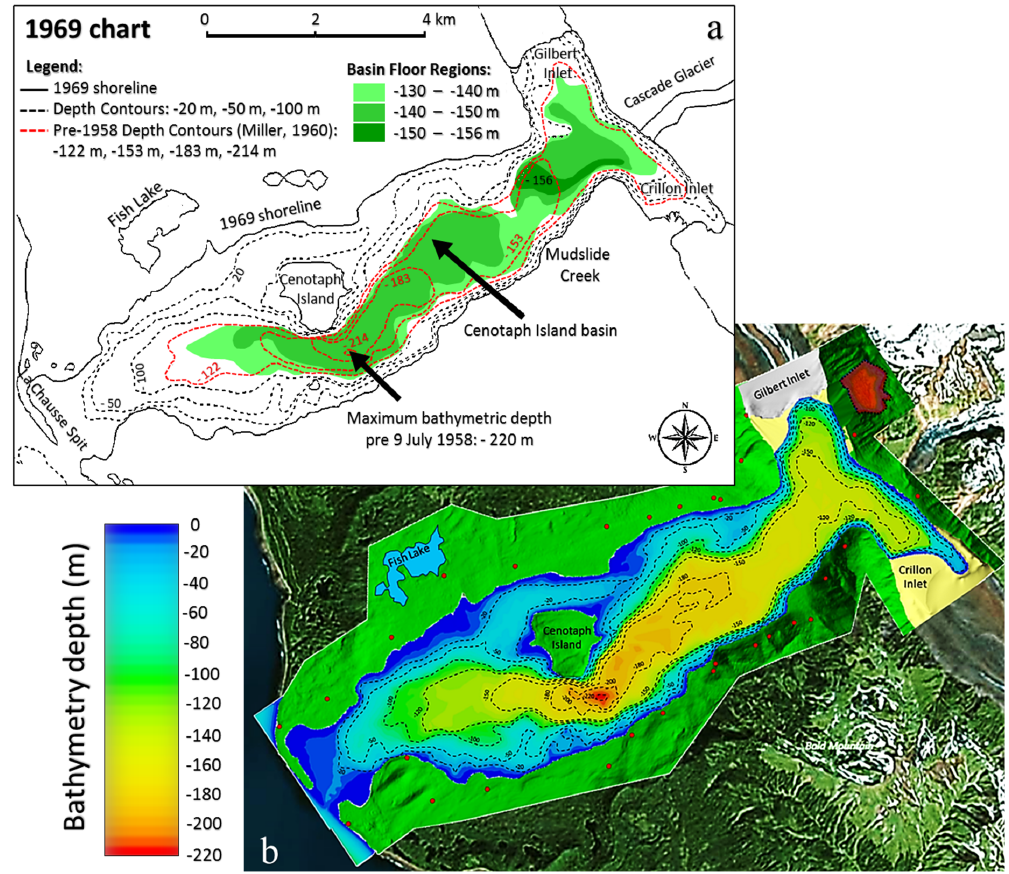
Figure 3. (a) The 1969 chart, based on a 1959 survey, highlights the flat bay floor (max. depth about − 150, − 156m) relative to the pre-1958 data (dashed red lines; max depth of − 220m) provided by Miller (1960) (modified from Ward and Day, 2010; see Fig. 8). (b) Reconstruction of the pre-1958 Lituya Bay bathymetry based on data from the U.S. Coast and Geodesic Survey, 1926, 1959; digital terrain model (DTM)